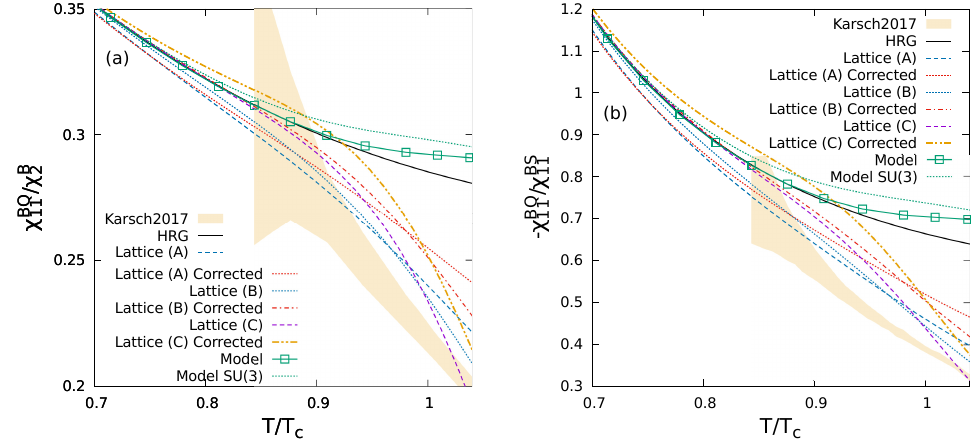
Figure 4. Ratios of the baryon–charge correlation to the baryon number fluctuation ( a ); and the baryon–strangeness correlation ( b